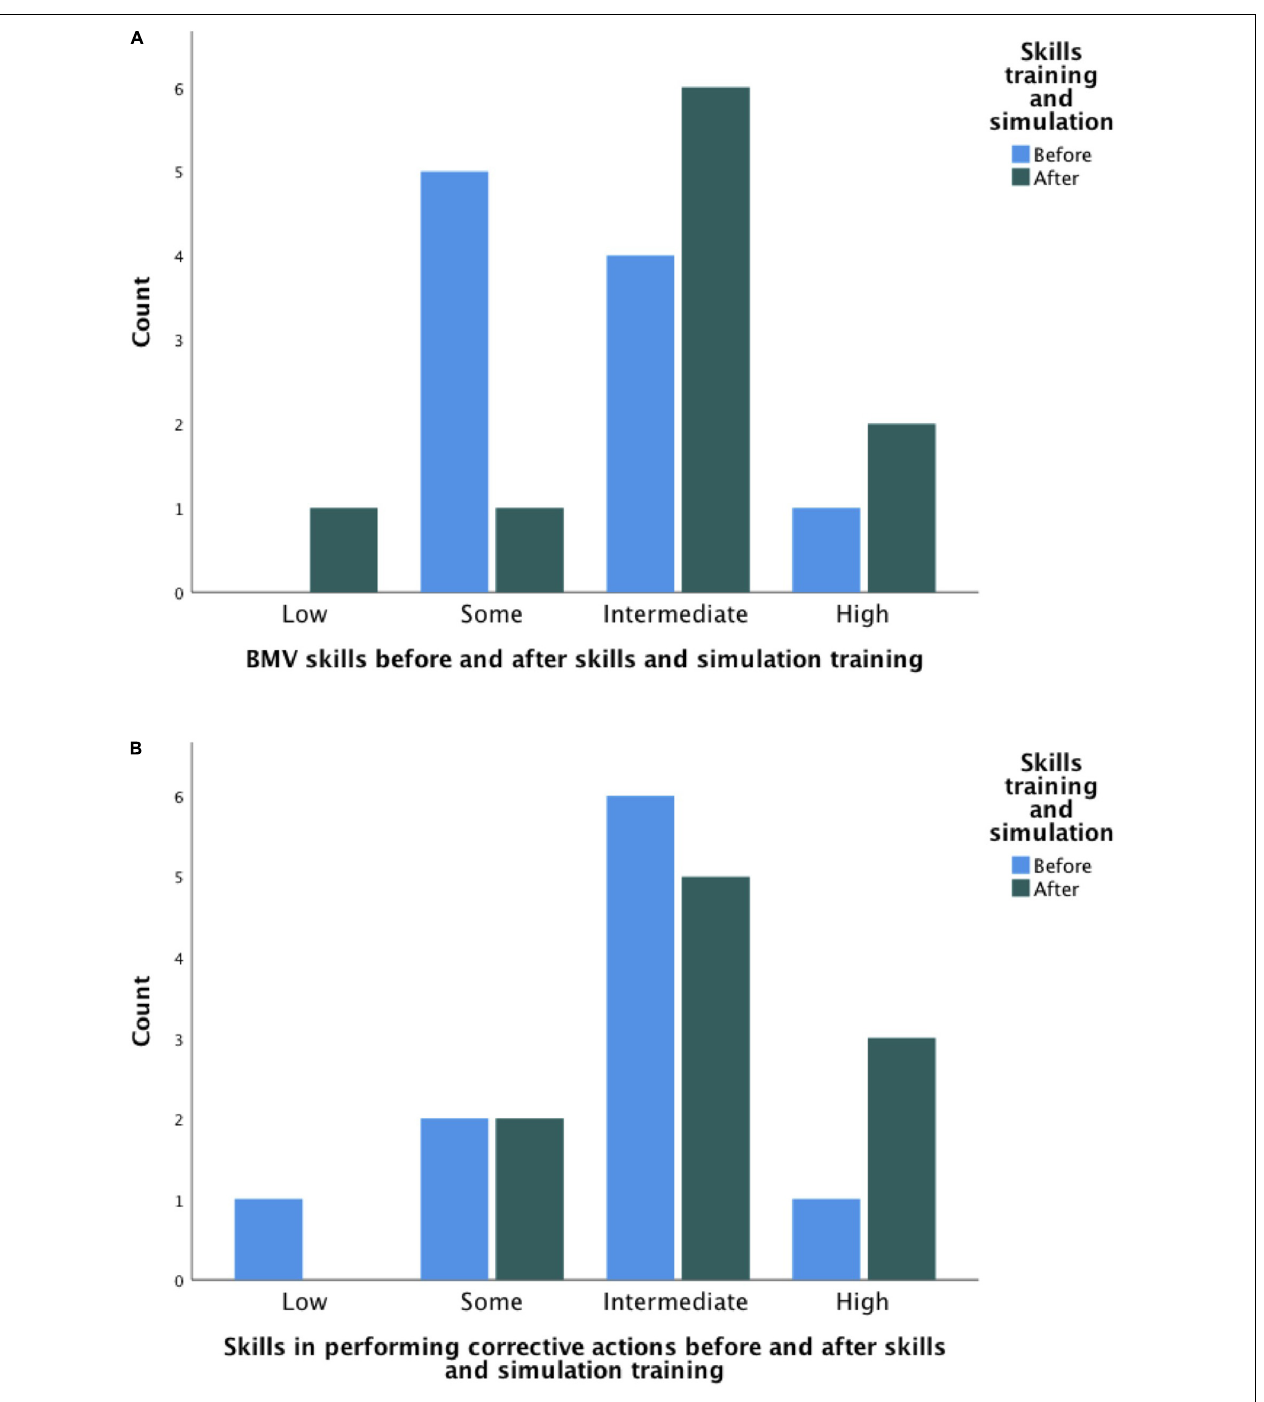
FIGURE 4 | Bar chart of students’ self-assessed skills in (A) bag-mask ventilation (BMV) and (B) ventilation corrective actions before (blue) and after (green) skills and simulation